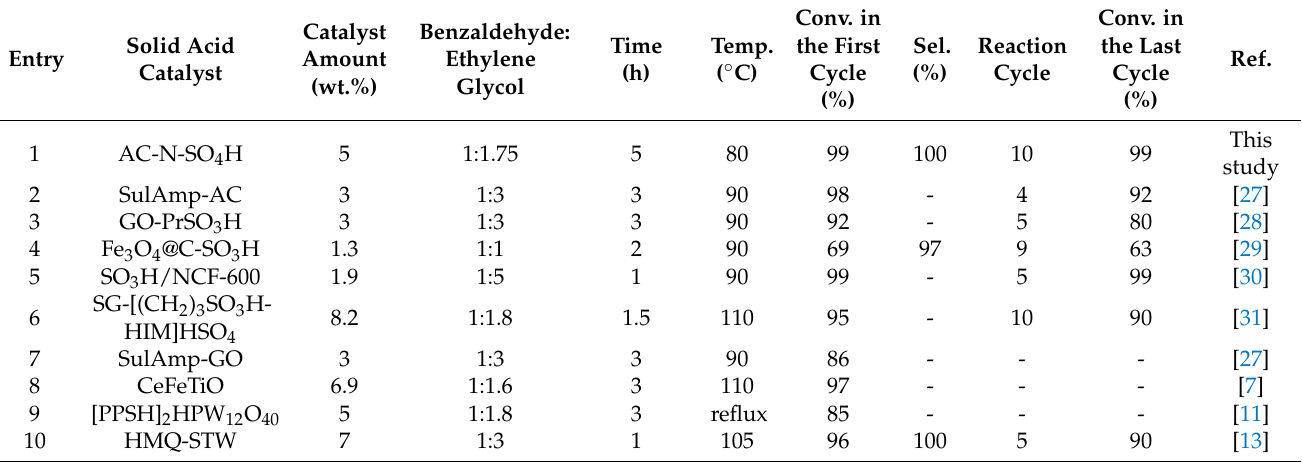
Table 2. Comparison of the catalytic efficiency of the prepared AC-N-SO 4 H catalyst with various